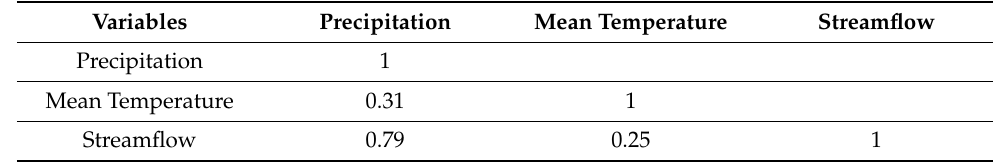
Table 3. Annual Pearson correlation between precipitation, temperature and streamflow during 1961–2016 (bold values show the significance at 95%).